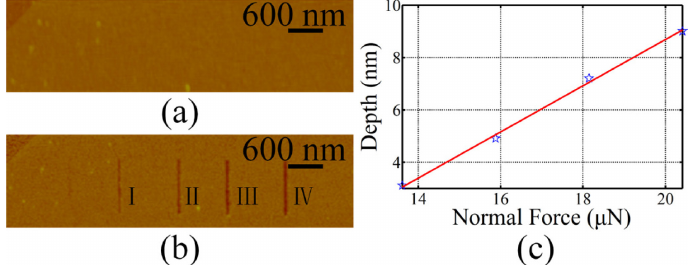
Figure 3. ( a ) Height image of the graphene before cutting; ( b ) height image of the graphene after cutting at different normal forces of 13.6 µ N (I), 15.88 µ N (II), 18.14 µ N (III), and 20.4 µ N (IV) with a cutting velocity of 2 µ m/s; and ( c ) the cut depth versus the normal force.